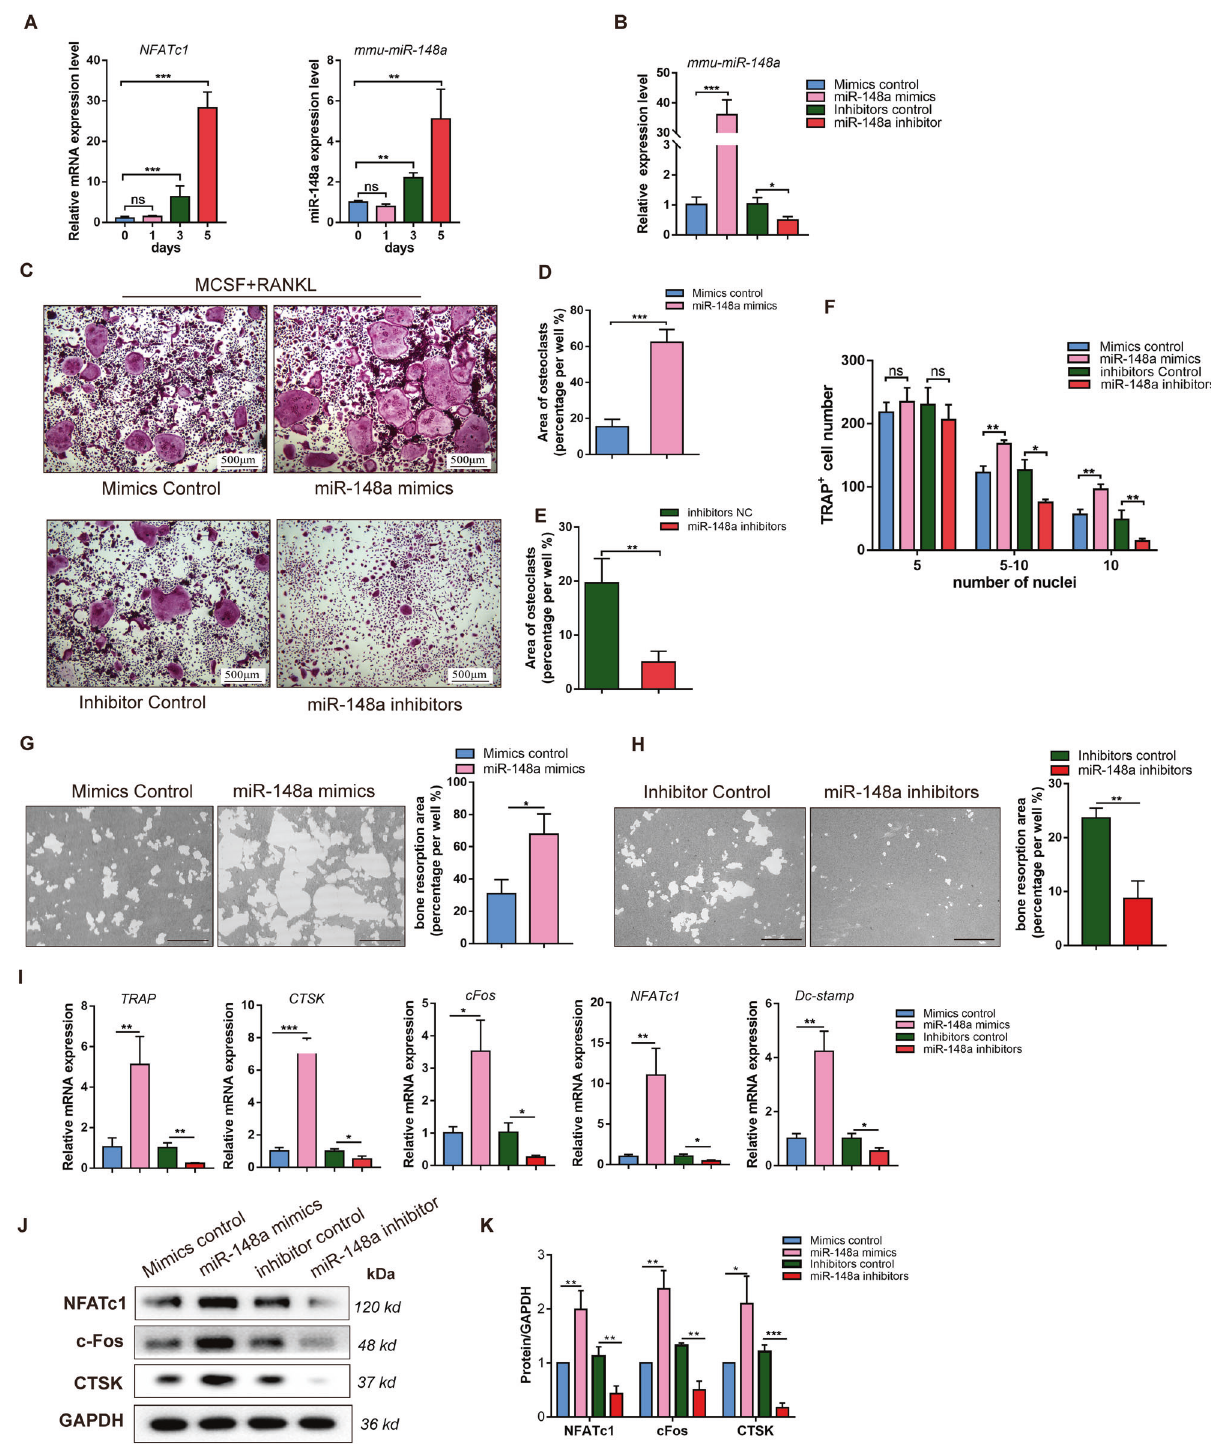
Fig. 2 miR-148a is a positive regulator in osteoclastogenesis in vitro. A The mature mouse miR-148a and NFATc1 expression level were determined by RT-qPCR during RANKL-stimulated osteoclastogenesis. B The transfection ef fi ciency of miR-148a mimics/inhibitors were evaluated by RT-qPCR. C The BMMs were transfected with miR-148a mimics/inhibitors and their corresponding control, and then cultured in osteoclast-inductive medium containing RANKL (50 ng/mL) for 4 days. TRAP staining was performed to observe the osteoclast formation; Scale bar, 500 μ m. D – F Quantitative analysis of osteoclast area and TRAP-positive multinucleated cell numbers, n = 3. G , H The BMMs were seeded on hydroxyapatite-coated 96-well plate and transfected with miR-148a mimics/inhibitors and their corresponding control for 5 days. The transfection was re-performed again at the third day. Quantitative analysis of bone resorption pit area per view; Scale bar, 200 μ m; n = 3. I The osteoclast-related gene expression of Nfatc1 , c-Fos , Ctsk , Trap , and Dc-stamp were determined (day4) by RT-qPCR; n = 3. J The protein expression of NFATc1, c-Fos, CTSK were determined by western blot. K Quantitative analysis of protein expression in J ; n = 3. (All data are presented as mean ± SD; * p < 0.05; ** p < 0.01; *** p < 0.001; ns, no signi fi cance, compared to the corresponding control group).